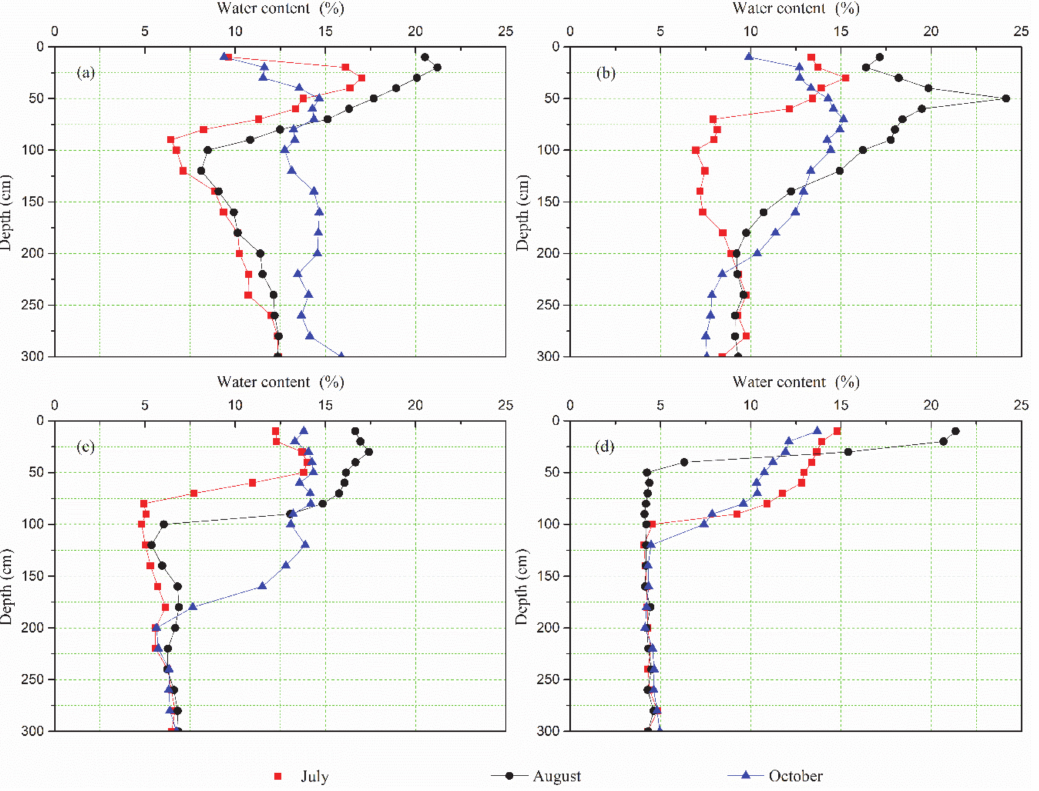
Figure 4. Profile distributions of soil water content under different land use types (( a ) cropland, ( b ) grassland, ( c ) shrubland, ( d ) woodland).